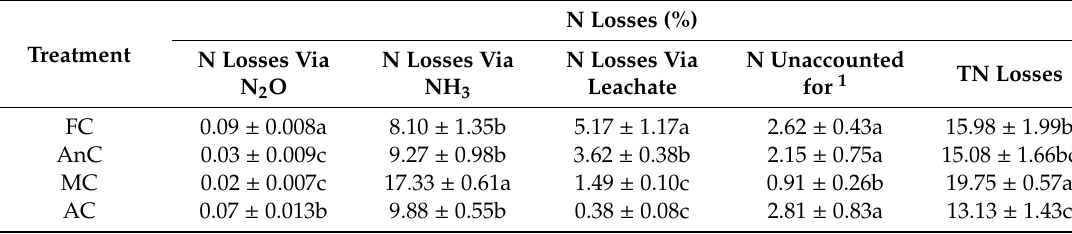
N mass balance for the compost mixtures in each treatment during the 39-day composting